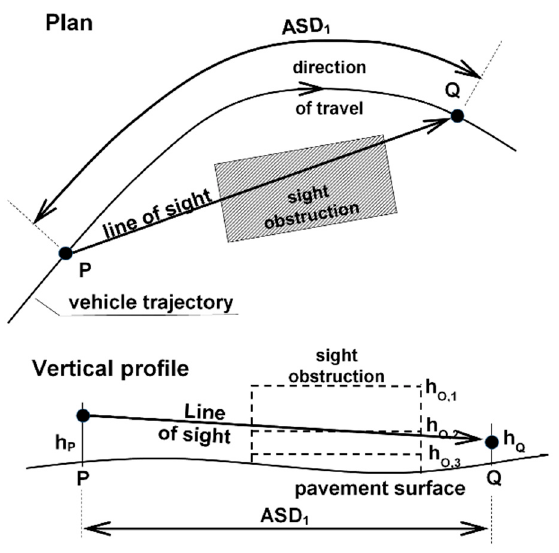
Figure 2. Estimation of the ASD along a road section with sight obstructions of different heights.